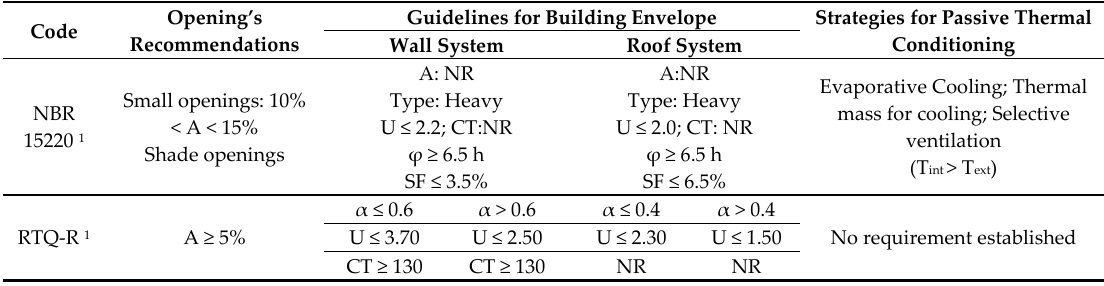
Table 1. Recommendations and constructive guidelines for bioclimatic zoning of the building